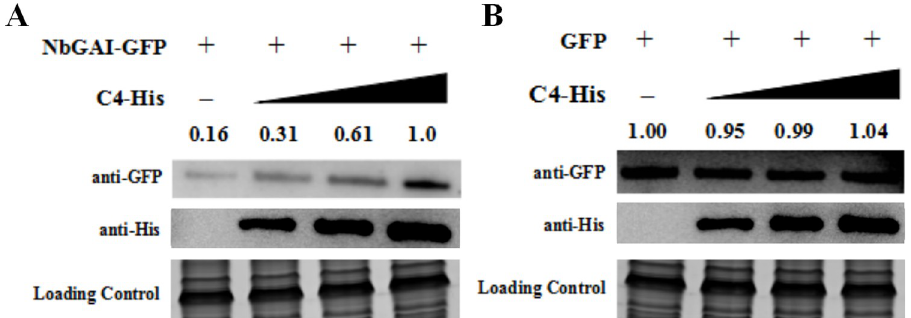
Fig 7. Inhibition of NbGAI degradation is C4 concentration dependent. (A) Agrobacterium culture carrying pGAI-GFP and Agrobacterium culture expressing C4-His (diluted to OD600 = 0, 0.25, 0.5 and 1.0, respectively) were co-infiltrated into N . benthamiana leaves. Two days later, total protein was extracted from different tissue samples and analyzed through Western blot analyses using an anti-GFP or an anti-His antibody. The CBB-stained RuBisCo large subunit gel shows equivalent sample loadings. (B) Western blot analysis shows that ALCScV C4 does not affect the stability of GFP in vivo .